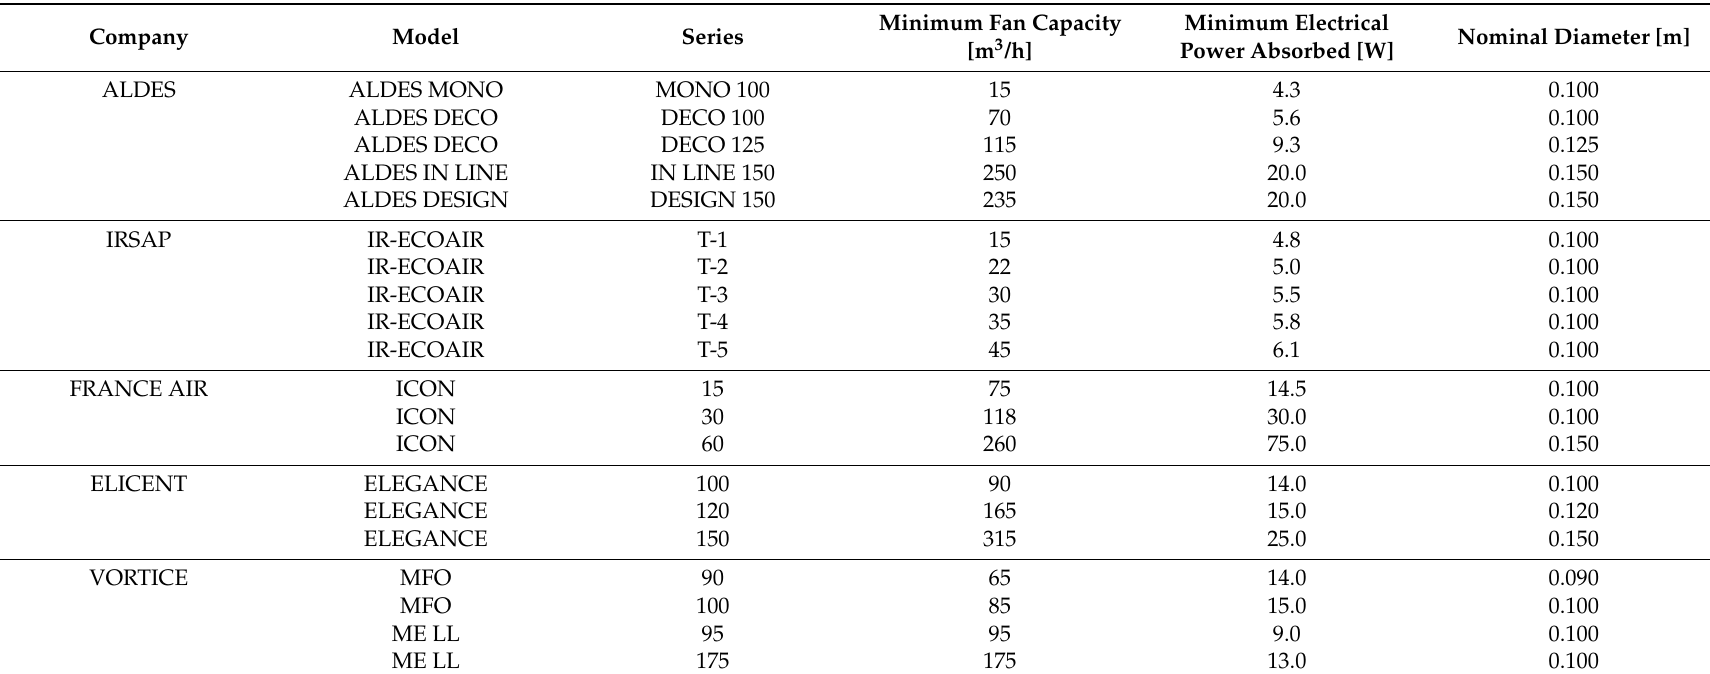
Table 1. Manufacturer’s data of selected